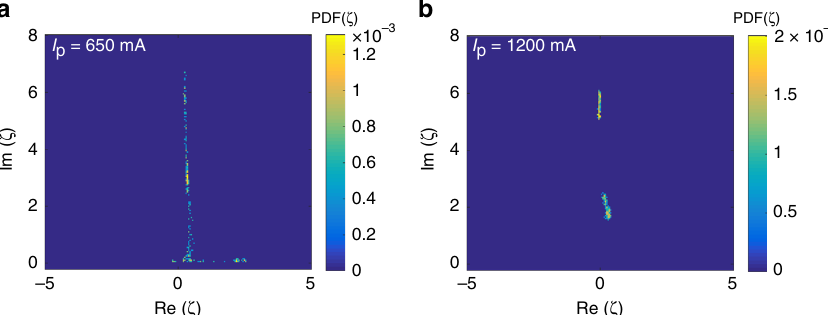
Fig. 3 Eigenvalue distribution in the complex plane of spectral parameters — Distribution of the NFT discrete eigenvalues (depicted on a complex plane of nonlinear spectral parameter ζ ), corresponding to the operational regimes of Fig. 2a, e obtained for an ensemble of 1000 mode-locked pulses. The improved stability of the laser at the higher power is evident from the well-de fi ned localised spots in the distribution of